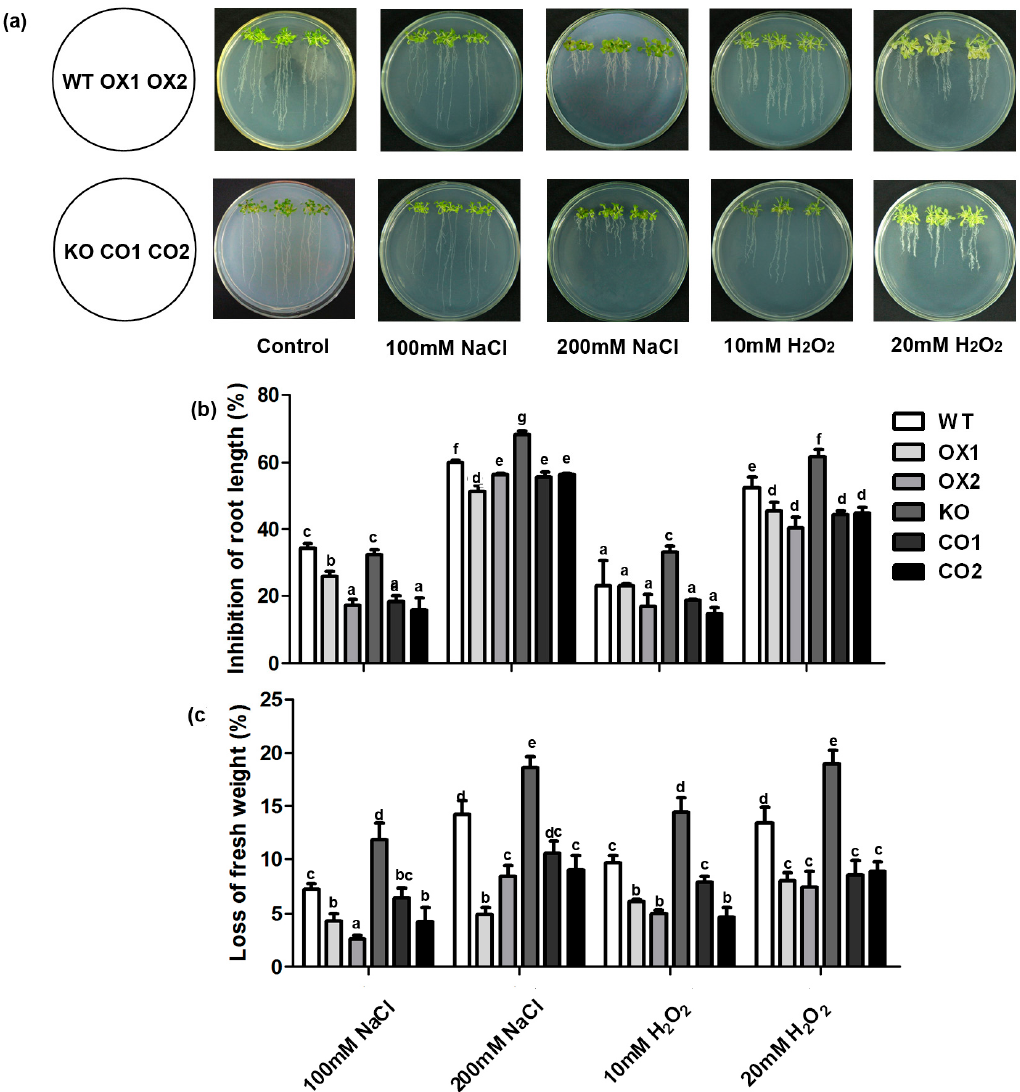
Figure 4. Analysis of salt and H 2 O 2 tolerance in transgenic Arabidopsis plants in comparison with the wild type and atsams3 mutant. ( a ) Phenotypes of wild type (WT), BvM14-SAMS2 - overexpressed seedlings in wild type Arabidopsis (OX), atsams3 mutant (KO), and BvM14-SAMS2 in mutant complementation seedlings (CO) under control and stress conditions. Photographs were taken 14 days after treatment. Inhibition of root length ( b ); and loss of fresh weight ( c ) were determined. Data are the means of three biological replicates (SD) and each replicate contains five seedlings. Different letters indicate significant difference at p < 0.05.